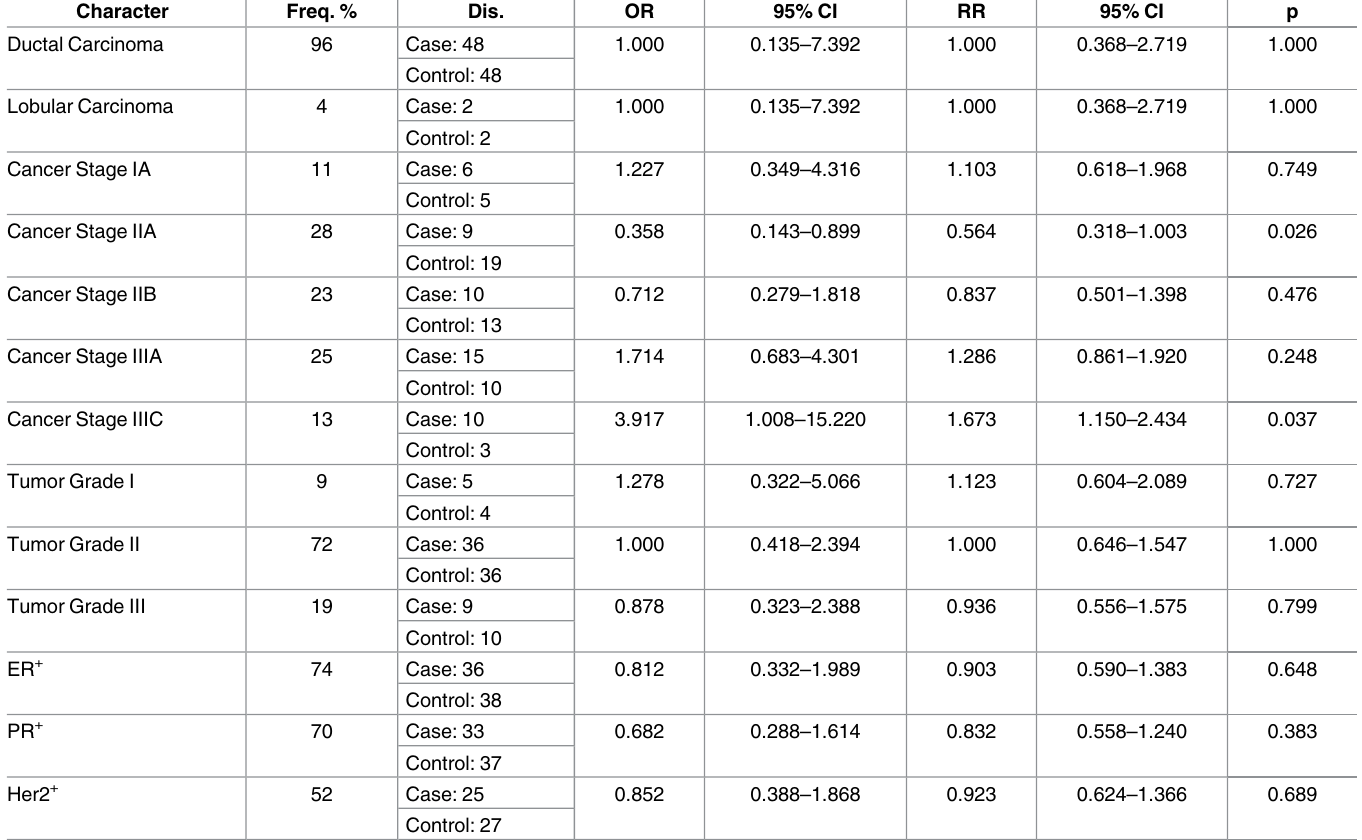
Table 5. Clinical characteristics of the